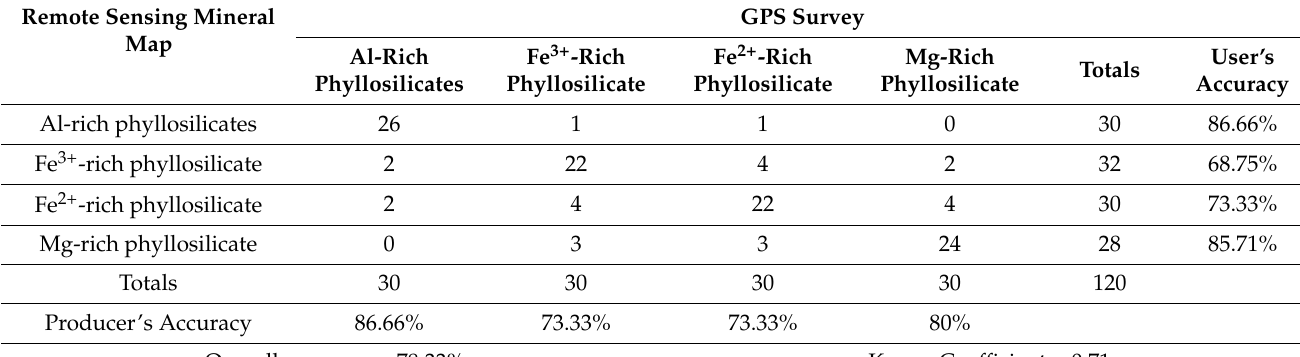
Table 6. Error matrix (confusion matrix) and Kappa Coefficient for remote sensing mineral maps versus field GPS survey. Remote Sensing